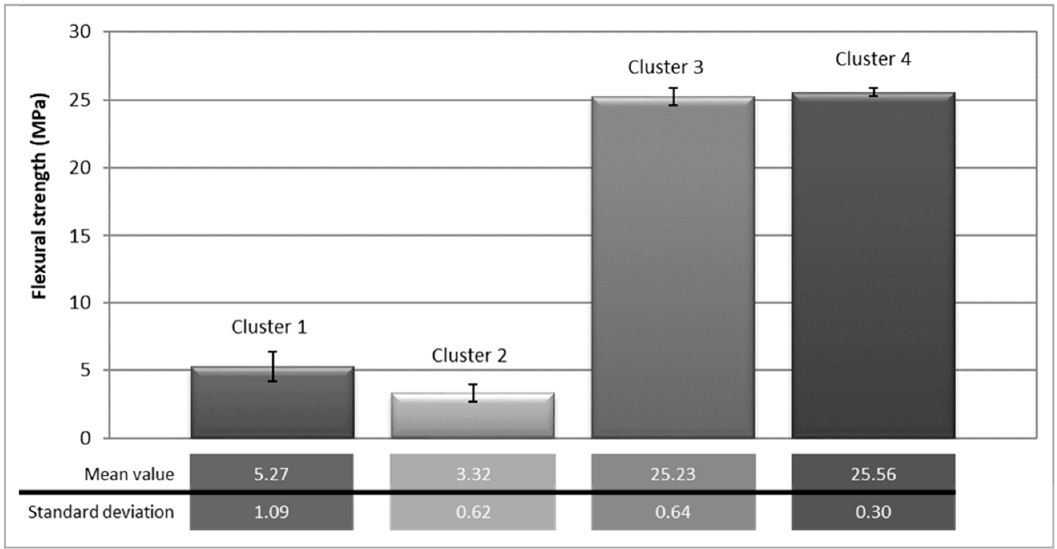
Figure 6. Flexural strength results by cluster.